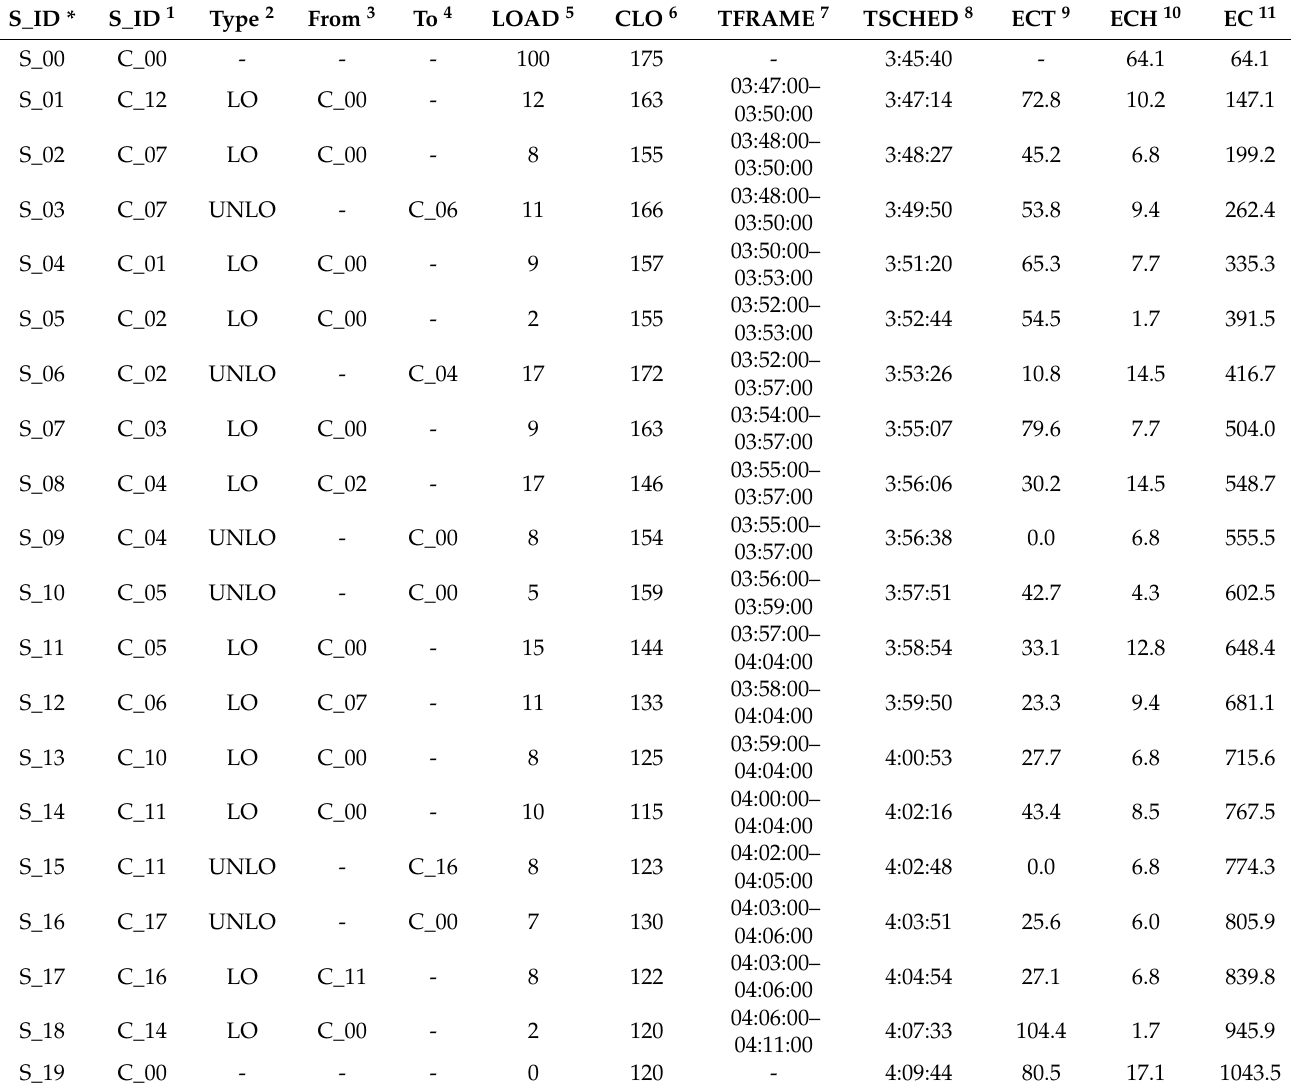
Table 4. Numerical results of the scheduling of predefined specific in-plant material supply operations performed by the milk-run trolley within route